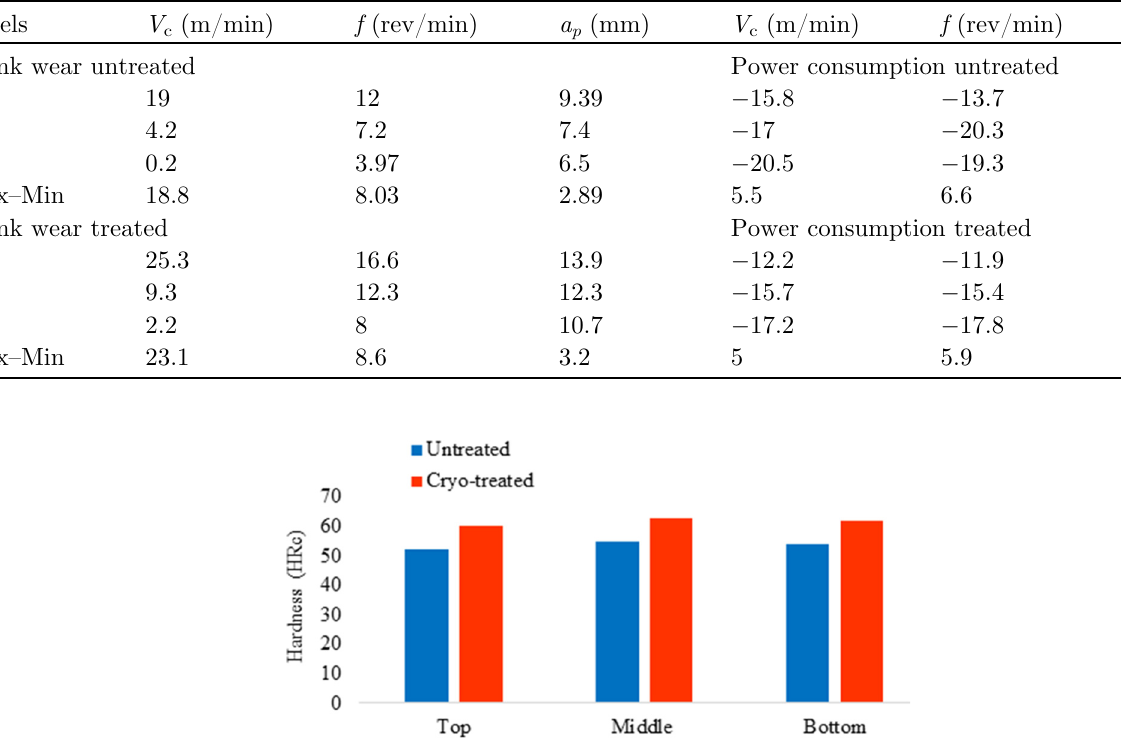
Table 9. Results of S / N ratio for fl ank wear and power consumption.